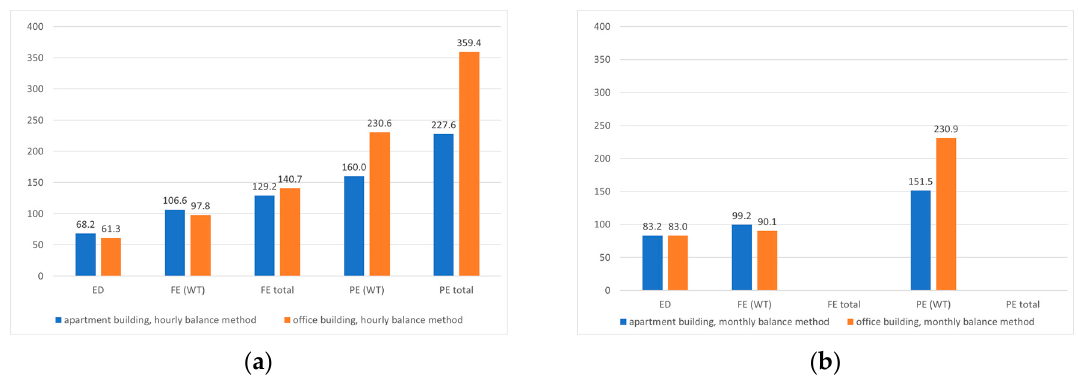
Figure 6. Comparison of energy demand for apartment building and office building, using: ( a ) Comparison of energy demand for apartment building and office building using hourly balance method, ( b ) Comparison of energy demand for apartment building and office building using monthly balance method; (ED—Energy Demand, FE—Final Energy, PE—Primary Energy, WT—calculations in accordance with Polish standards).